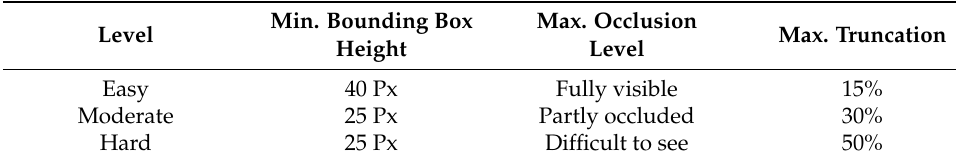
Table 1. The difficulty level provided by the KITTI dataset. Min. Bounding Box Max. Occlusion Level Max. Truncation Height Level Easy 40 Px Fully visible 15% Moderate 25 Px Partly occluded 30% Hard 25 Px Difficult to see